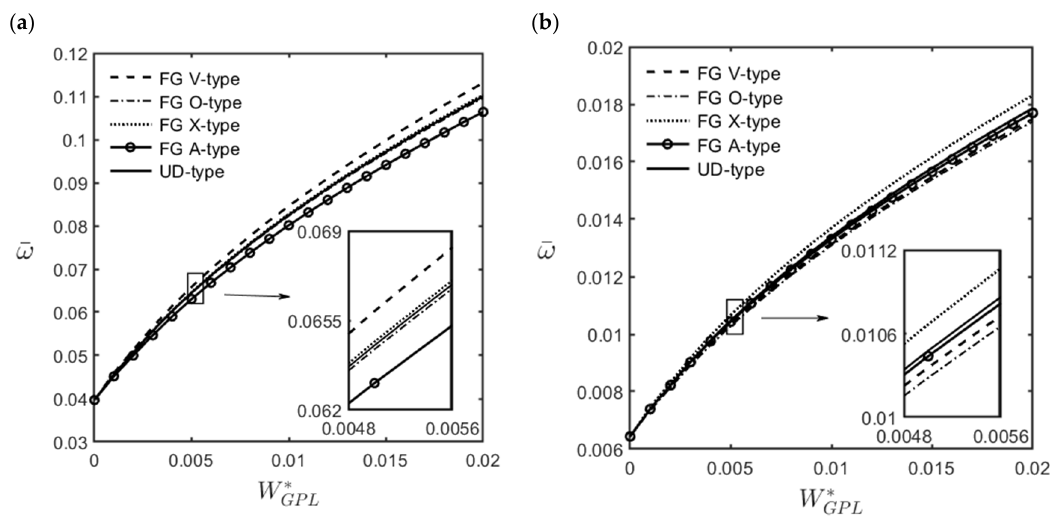
Figure 8. Variations in the dimensionless fundamental frequencies of an FG-GPLRC cylindrical microshell with the weight fraction of GPL for different GPL distribution patterns, for which ˆ l / h = 1.0, and ( a ) R / h = 5, L / R = 5, and ( ˆ m , ˆ n ) = (1, 1), ( b ) R / h = 20, L / R = 5, and ( ˆ m , ˆ n ) = (1, 2).